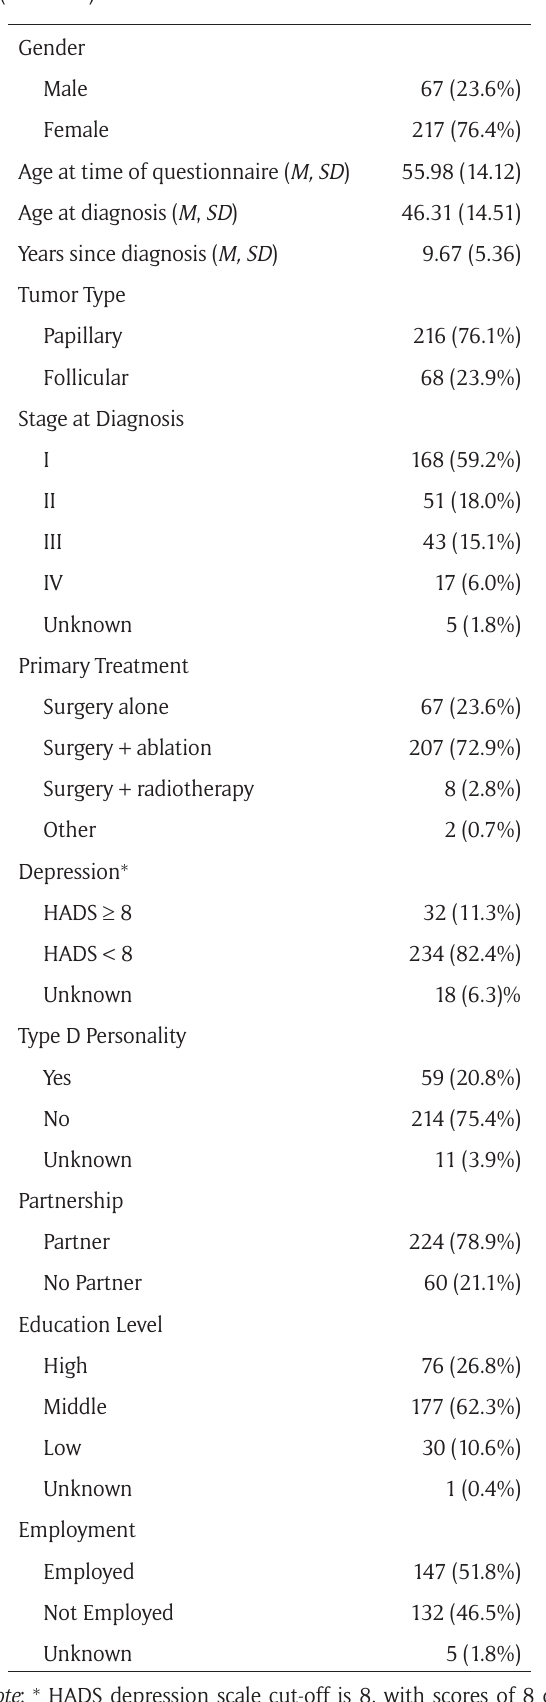
Table 1: Descriptive characteristics of participants ( N =